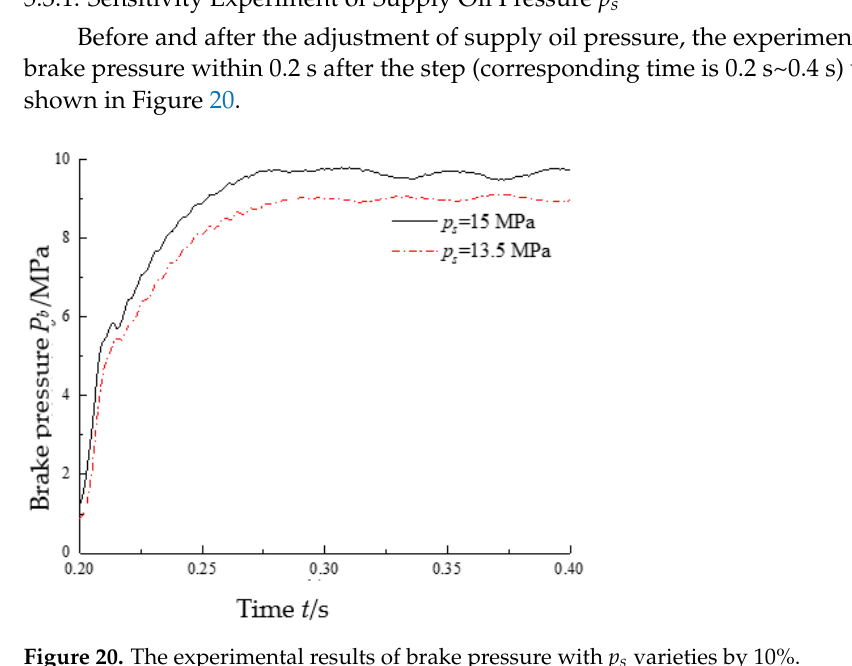
Figure 20. The experimental results of brake pressure with p s varieties by 10%.